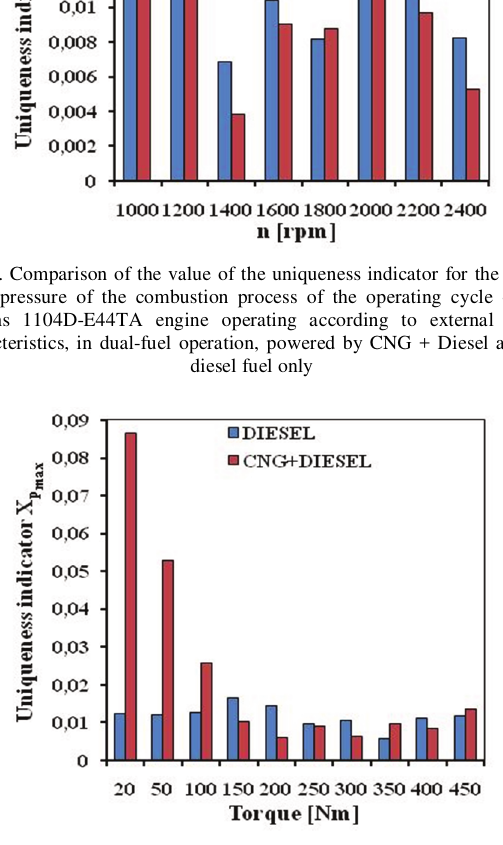
Fig. 9. Comparison of the value of the uniqueness indicator for the maxi- mum pressure of the combustion process of the operation cycle in the Perkins 1104D-E44TA engine cylinder, running according to load charac- teristics for crankshaft speed n = 1800 rpm, in dual-fuel operation